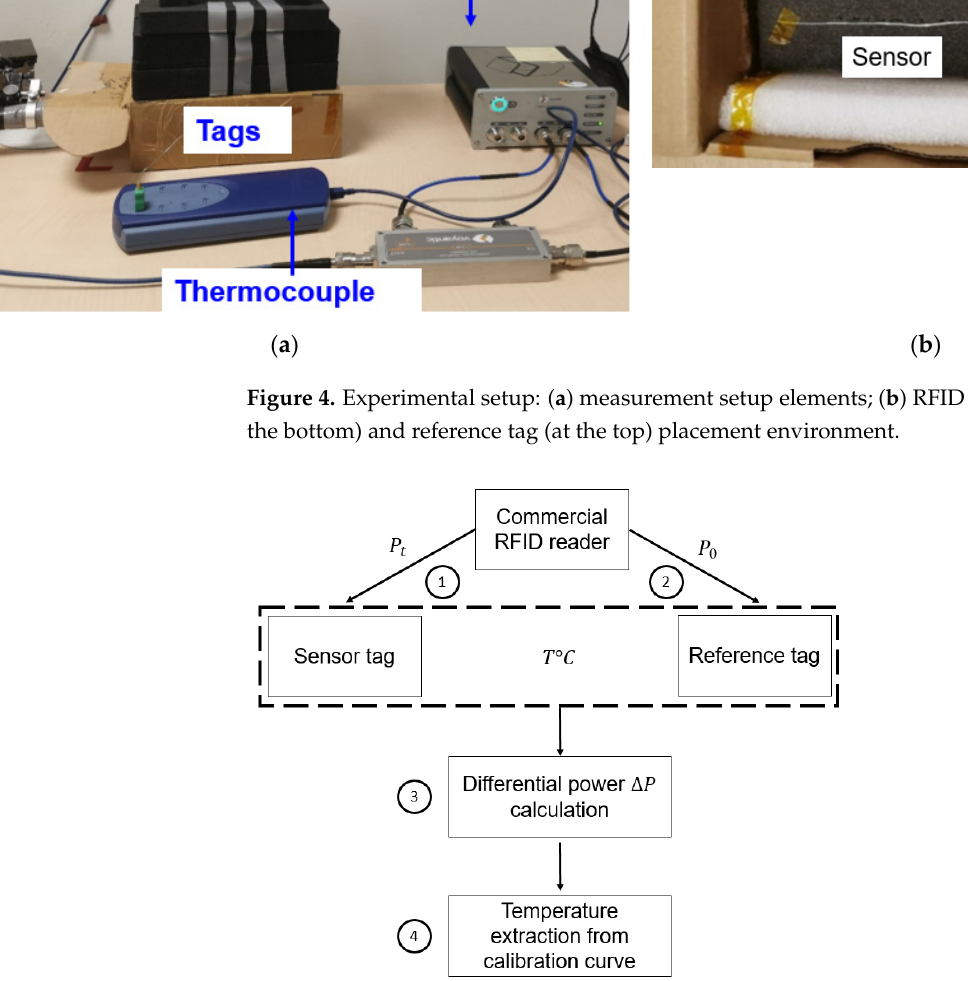
Figure 4. Experimental setup: ( a ) measurement setup elements; ( b ) RFID temperature sensor tag (at the bottom) and reference tag (at the top) placement environment.